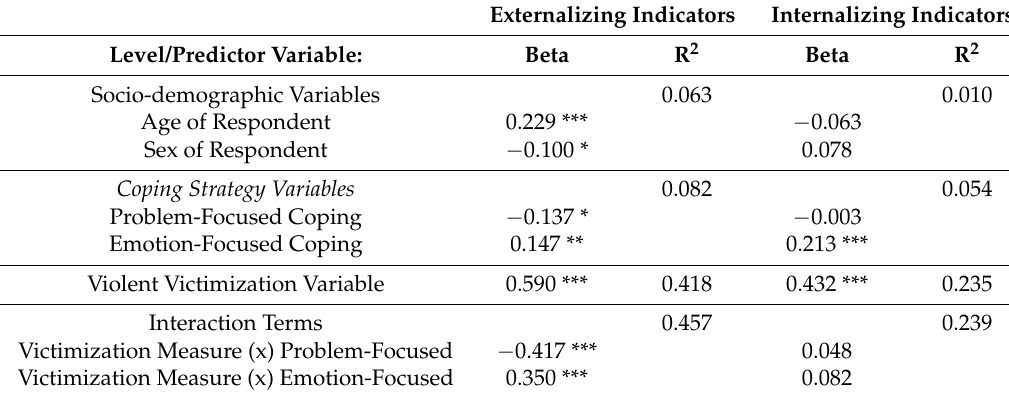
Table 1. Hierarchical Multiple Regression Analysis Calculating Adolescent Symptomatology Scores from Exposure to Violence and Victimization and Coping Approach as